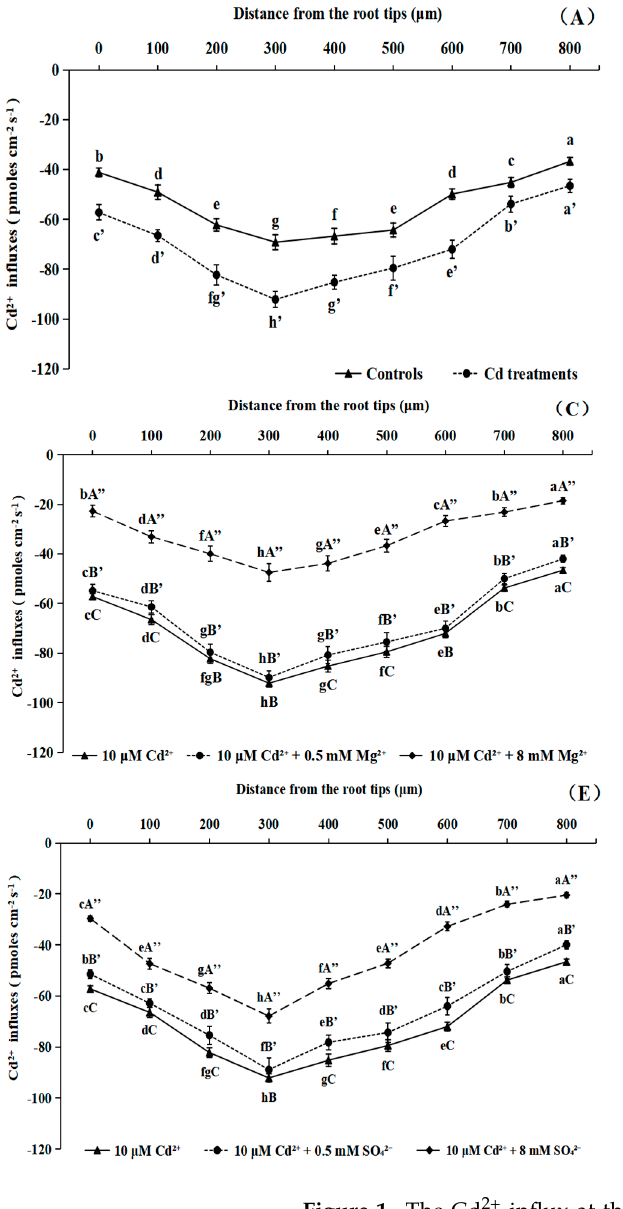
Figure 1. The Cd 2+ influx at the root surface of Bidens pilosa L. from control groups ( A ) and Cd treatment groups with different concentrations of Ca 2+ ( B ), Mg 2+ ( C ), Fe 2+ ( D ), SO 4 2 − ( E ) and K + ( F ). Notes: The negative values of Cd 2+ net flux denote the influx from the measuring solution to the root. The means of Cd 2+ influx at different distances from the root tips marked with the same lowercase letters (a–h) were not significantly ( p > 0.05) different, and the means of Cd 2+ influx under different treatments marked with the same capital letters (A–C) were not significantly ( p > 0.05)